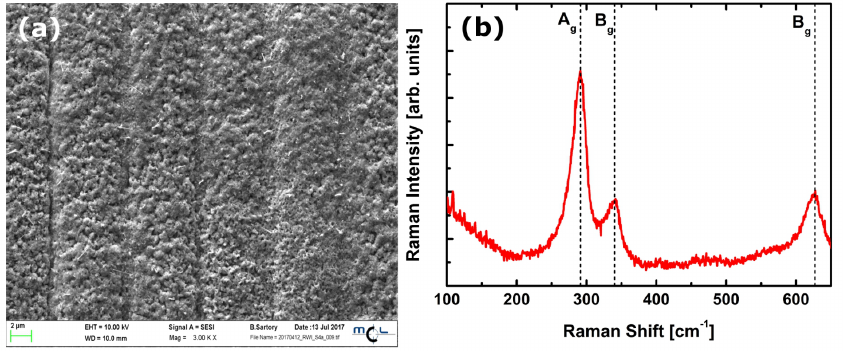
Figure 2. ( a ) SEM picture of the thermally oxidized CuO film. ( b ) Raman spectrum of the thermally oxidized CuO